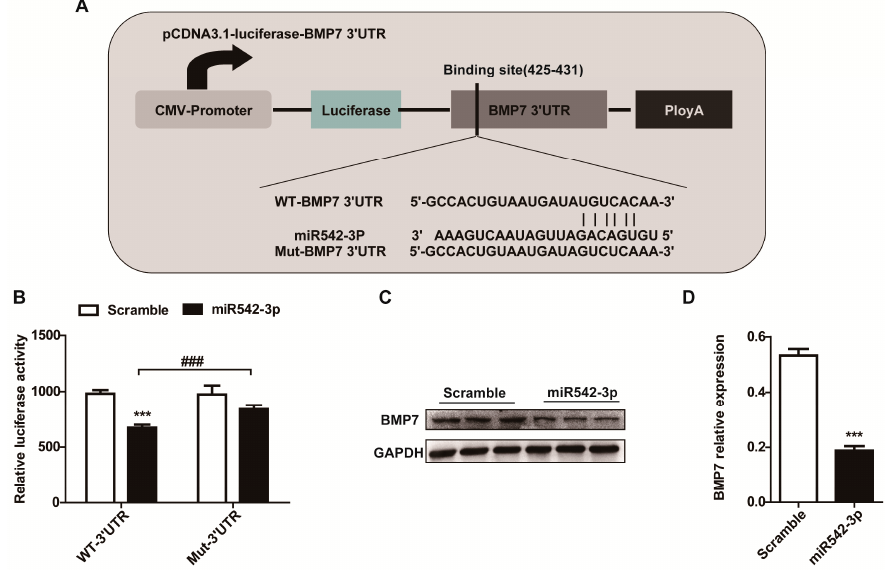
Figure 4. MiR542-3p targets BMP7 3 ′ UTR and suppresses the expression of the BMP7 protein. ( A ) Schematic presentation of the miR542-3p binding site in the BMP7 3 1 UTR and wild type or mutant BMP7 3 1 UTR luciferase reporter vector structures; ( B ) Dual-luciferase reporter assays indicated that the luciferase activity was suppressed in 293T cells transiently transfected with miR542-3p and wild type BMP7 3 1 UTR reporter vector. However, the suppression of luciferase activity was eliminated when the binding site of miR542-3p was mutated in BMP7 3 1 UTR; ( C ) Western blot analysis of BMP7 expression levels in NRK52e cell transfected with control mimic or miR542-3p; ( D ) Histogram showed the gray scale quantitative analysis for Western blot results. All data are displayed as means ˘ SD from three independent experiments, ### p < 0.001, *** p < 0.001.